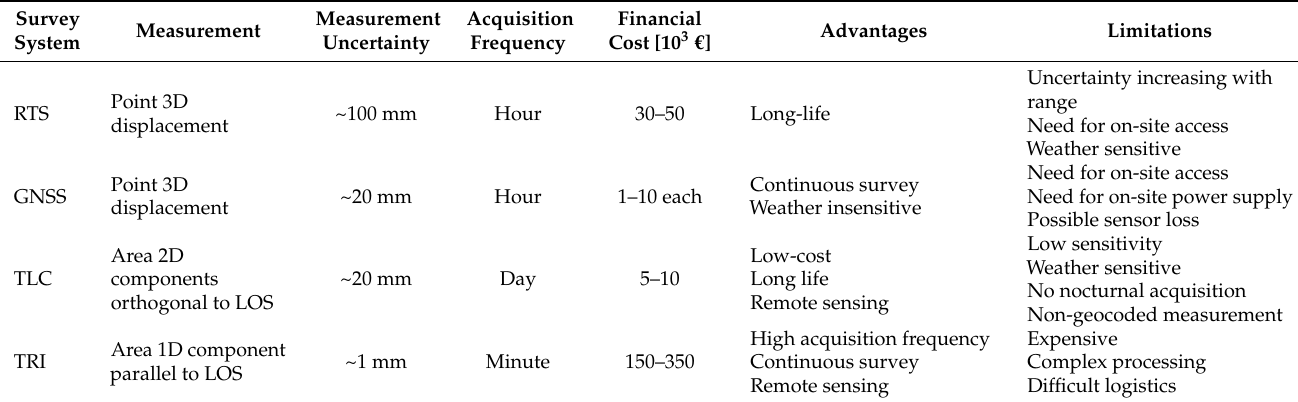
Table 2. Main characteristics, advantages, and limitations of the considered survey systems. Survey